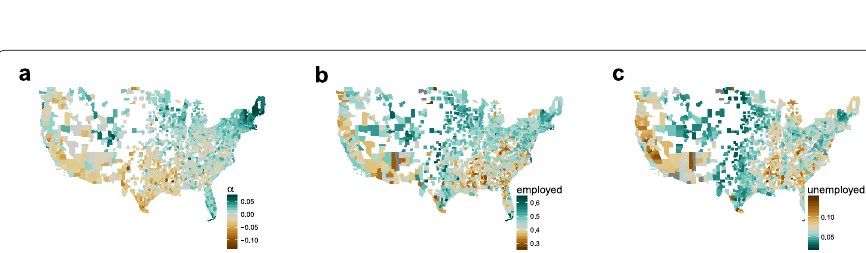
Figure 6 Map of α ( k ) , employment and unemployment levels. Regional similarities are visualized by plotting a α ( k ) measures, employment b and unemployment c on a US county map. Blank counties did not exceed the 1800 tweet threshold described in the Methods section.